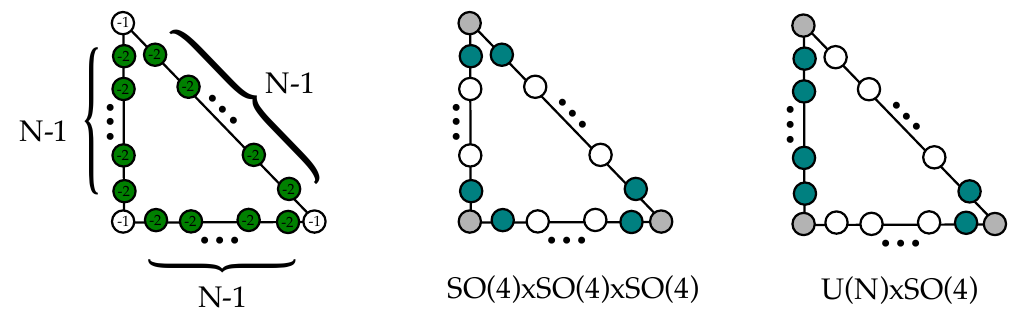
Figure 19 . BG-CFDs for T N : on the left hand side we show the full CFD for T N . The two diagrams on the right are the possible embeddings of BG-CFDs. The IR (cid:13)avor symmetries are shown below each